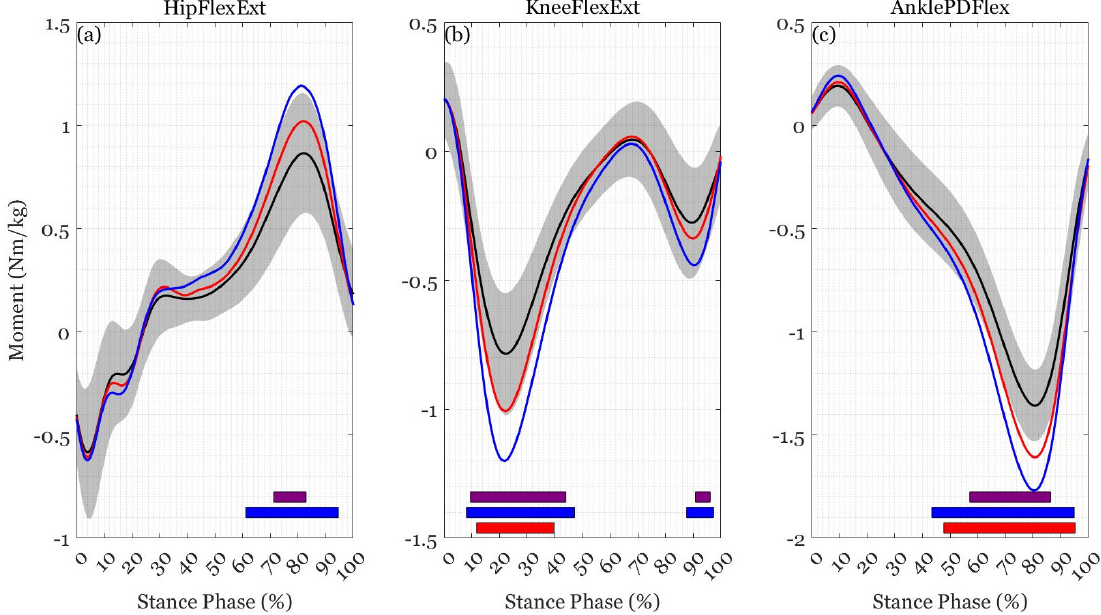
Figure 2. Mean trajectories for ( a ) hip joint flexion-extension moment, ( b ) knee joint flexion-extension moment, and ( c ) ankle joint plantar-dorsiflexion moment during load carriage of 0% BM (black), 20% BM (red), and 40% BM (blue). The colored bars show when the SPM { t } critical threshold was exceeded between 0% BM and 20% BM (red), 0% BM and 40% BM (blue), and 20% BM and 40% BM (purple).